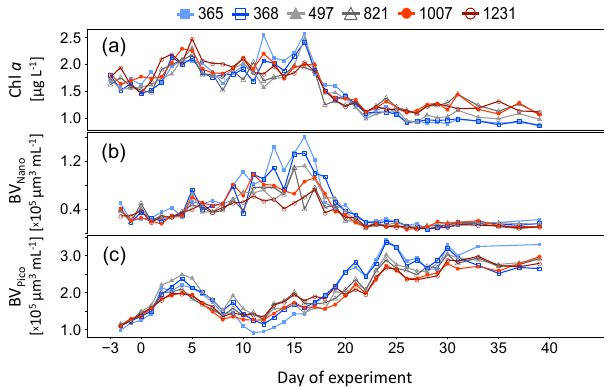
Figure 2. (a) Concentration of chlorophyll a [µgL − 1 ], (b) biovol- ume of nanophytoplankton (Nano I and Nano II) [ × 10 5 µm 3 mL − 1 ] and (c) biovolume of picophytoplankton ( Synechococcus spp., Pico I-III) [ × 10 5 µm 3 mL − 1 ] during the course of the experiment. Colours and symbols indicate average f CO 2 [µatm] between t 1 and t 43.